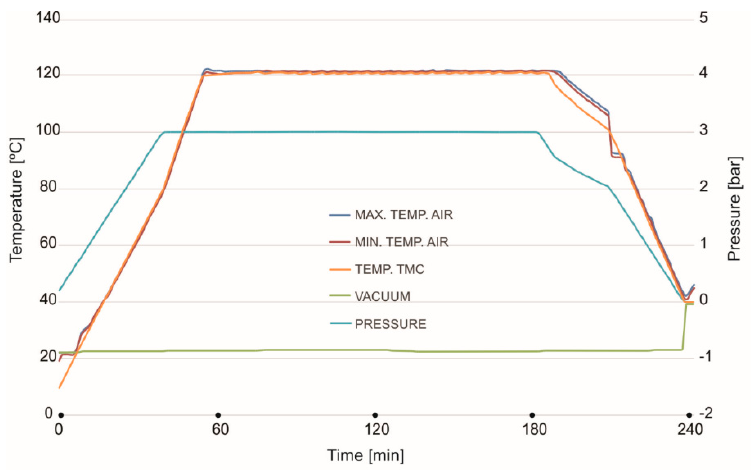
Figure 4. Autoclave curing cycle diagram.